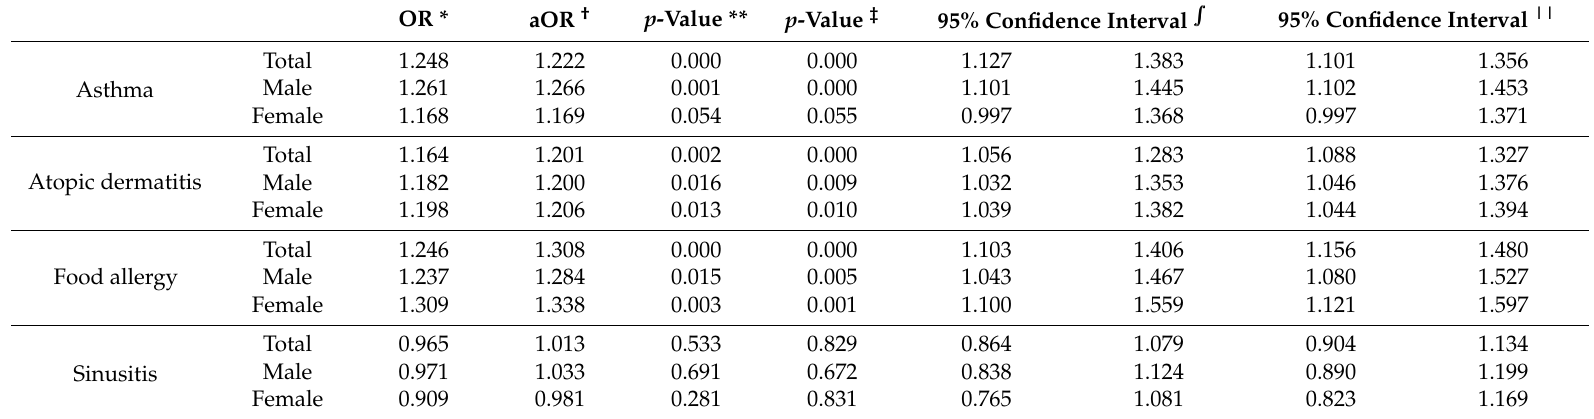
Table 3. Odds ratio for having comorbid disease in the AR group compared with NAR